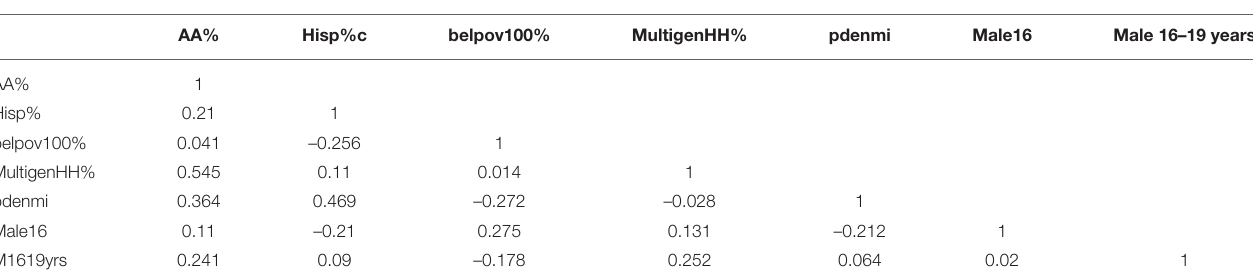
TABLE A1 | Correlation between independent